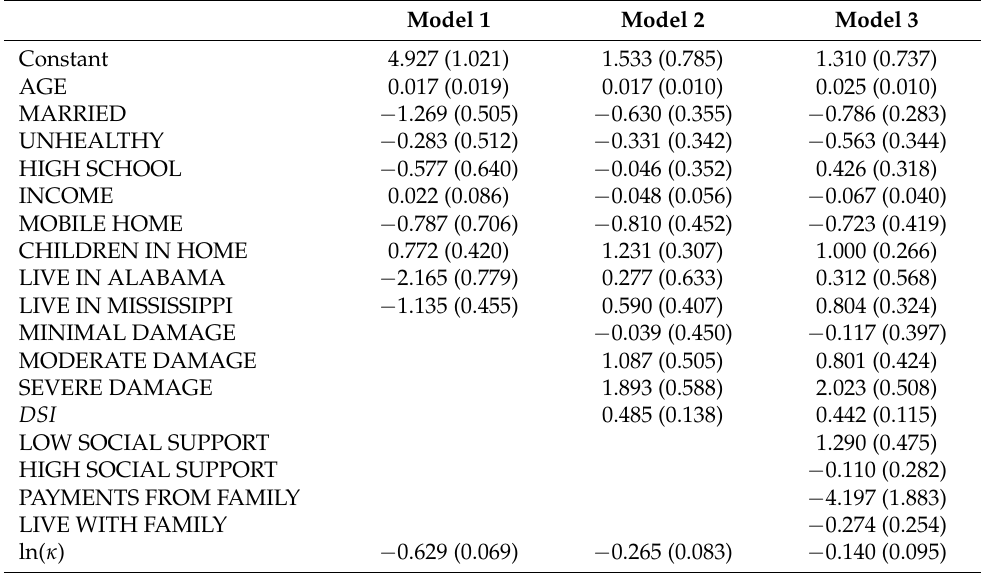
Table 4. The Result from Survival Component of Hurdle Model (Displacement